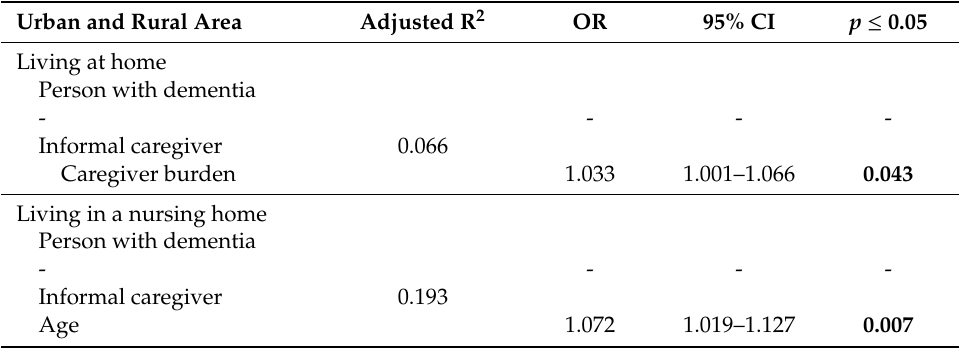
Multivariate regression analysis of associated factors of people with dementia and their